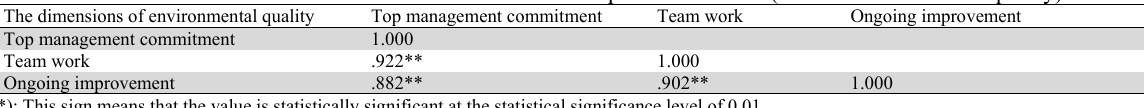
Pearson correlation coefficient values of the dimensions of the dependent variable (i.e. the environmental quality) The dimensions of environmental quality